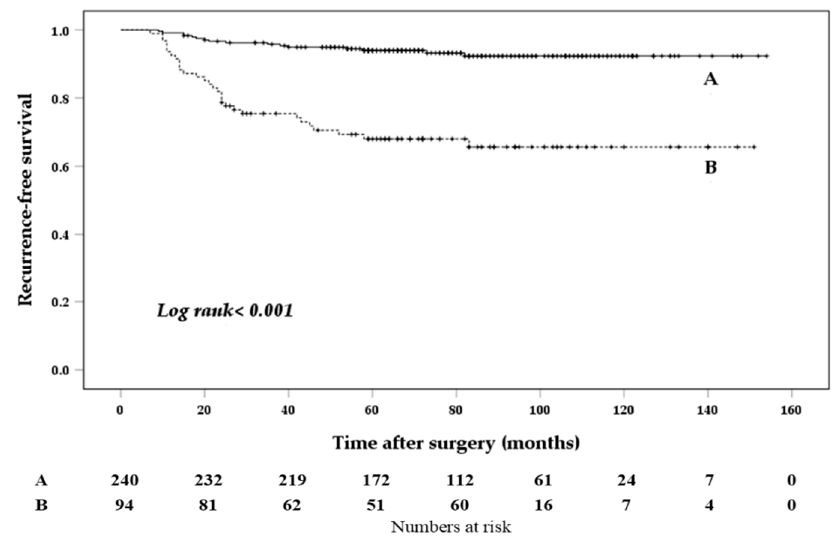
Figure 3. Kaplan-Meier curve according to the level of stimulated thyroglobulin (Tg). Tg ≤ 7.3 ng/mL ( A ), Tg > 7.3 ng/mL ( B ). The optimal cutoff value for the central LN ratio, lateral LN ratio, and stimulated Tg level was 0.68 (area under the curve (AUC), 0.626; sensibility, 58.7%; specificity, 68.1%), 0.21 (AUC, 0.633; sensibility, 76.1%; specificity, 51.0%), and 7.3 ng/mL (AUC, 0.763; sensibility, 65.2%; specificity, 77.8%) on ROC curve analysis, respectively (Figure 4).